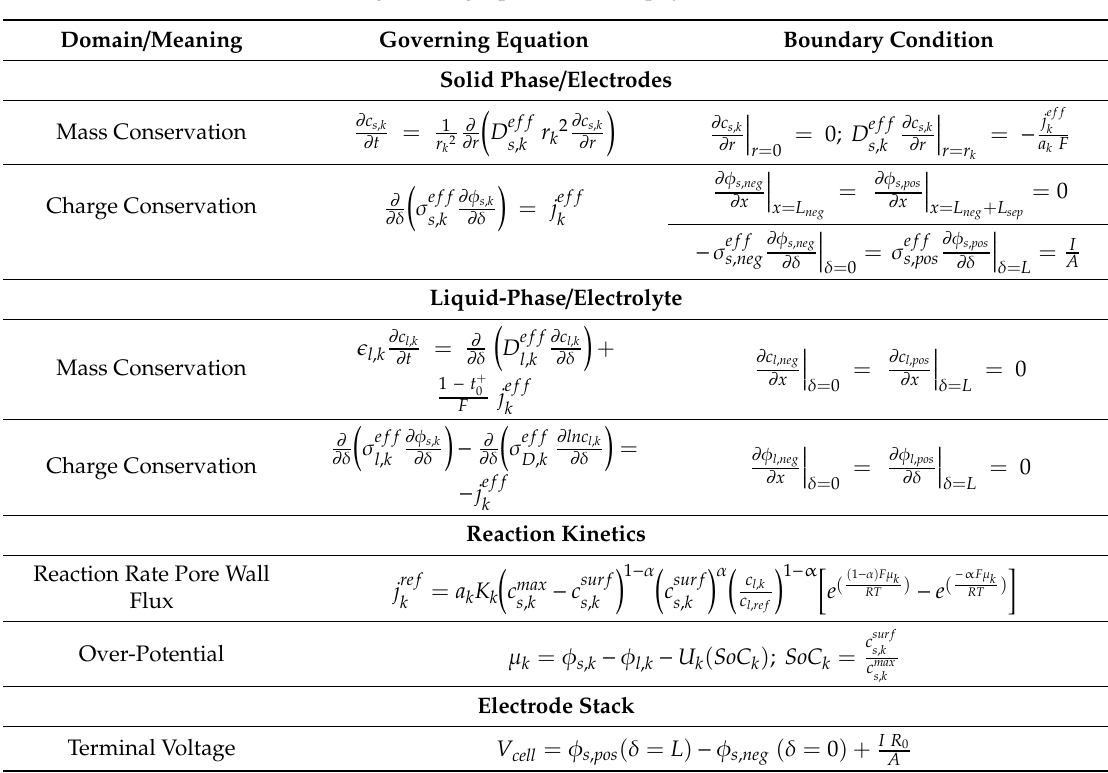
Table A1. The governing equations of the physicochemical